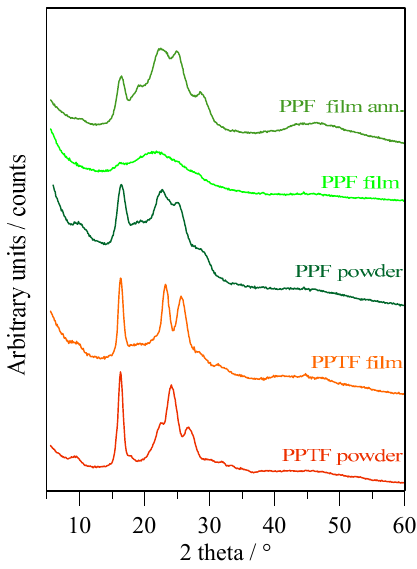
Figure 6. X-ray diffraction profiles of PPTF powder, PPTF film, PPF powder, PPF film and PPF film after annealing for 45 min. at 110 °C.